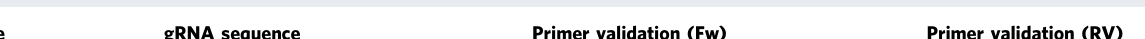
Table 1 gRNA sequence and genomic PCR